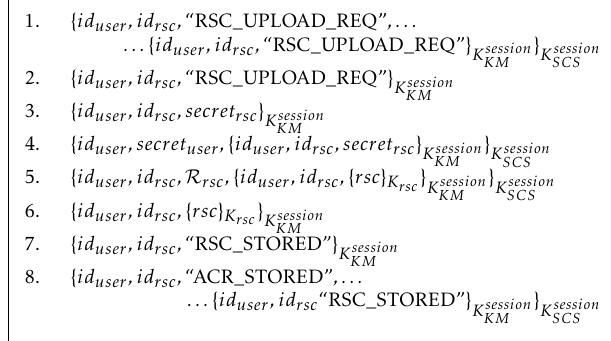
Figure 9. Contact list update: messages exchange